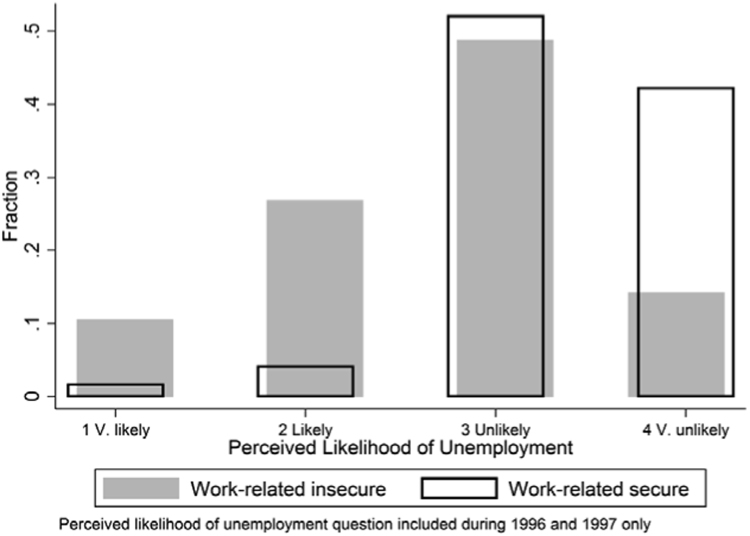
Comparison of Unemployment Expectations and Work-related Insecurity Classification (1996 and 1997 only).